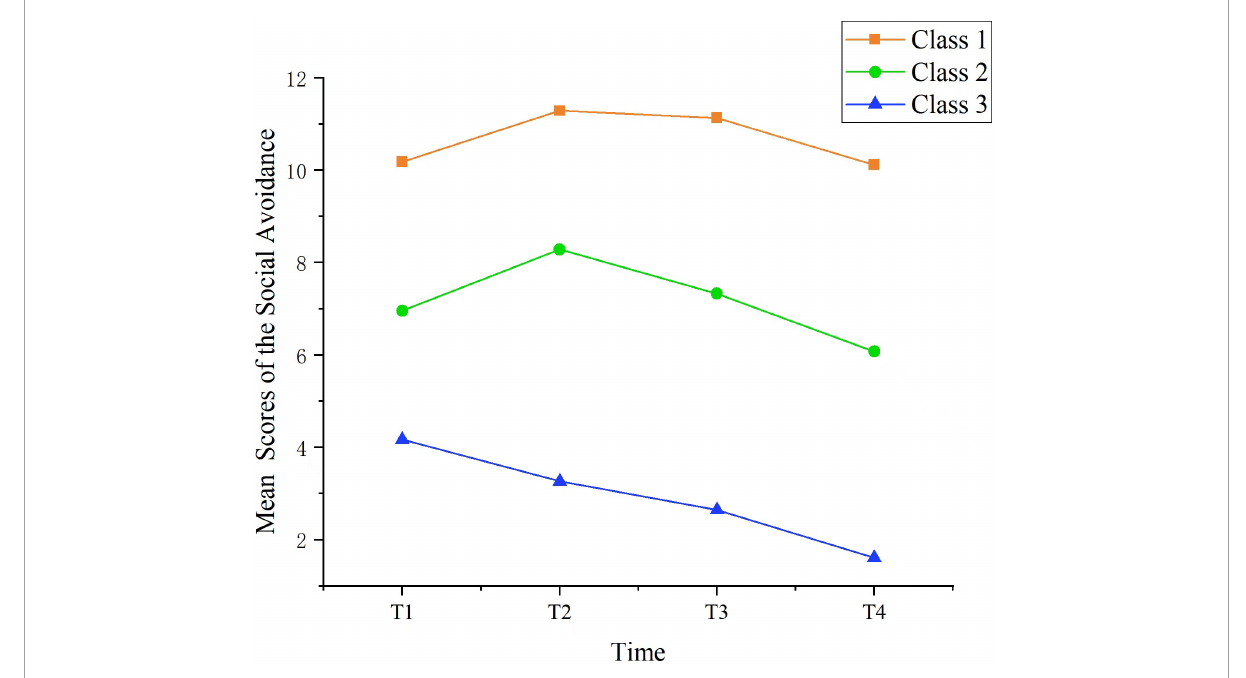
FIGURE1 Three classes of growth trajectory of social